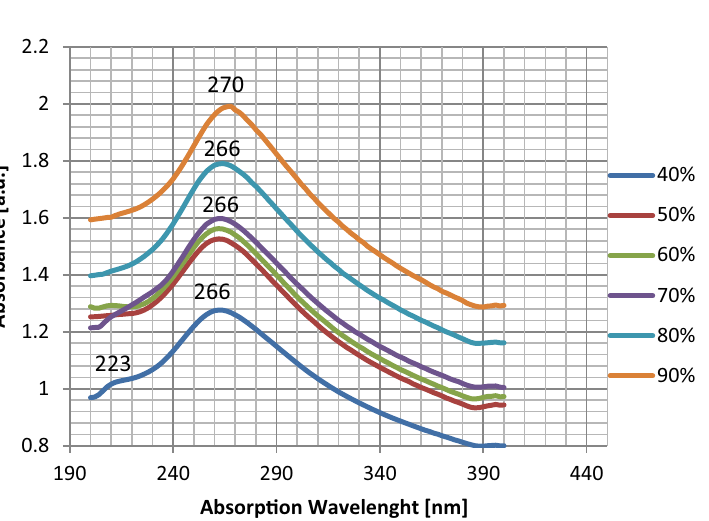
Figure 3. Simulated effect of power variation on the maximum and the minimum probe acoustic pressure in the cylindrical reactor (vessel).